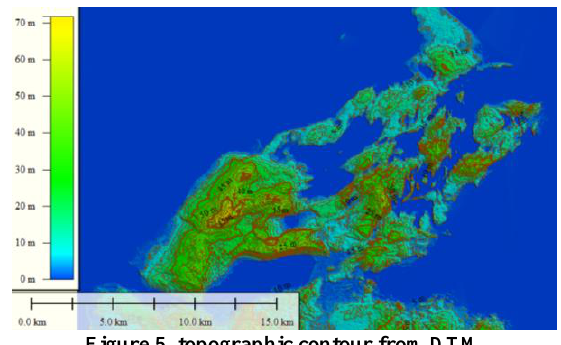
Figure 5. topographic contour from